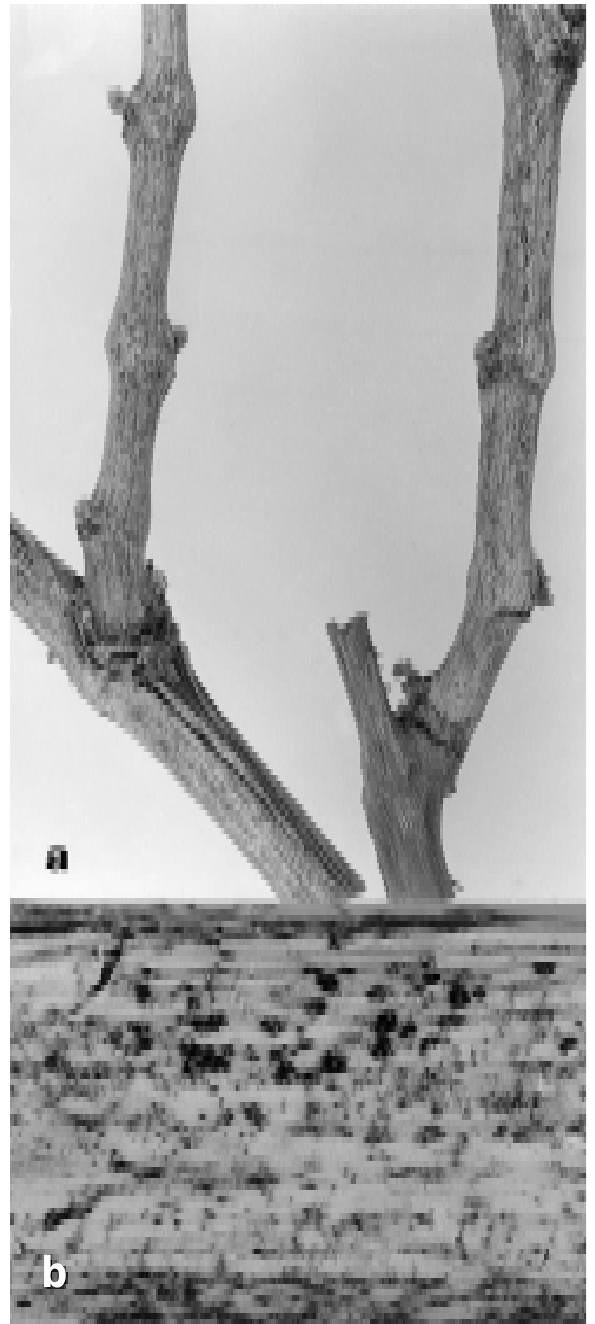
Fig. 1. a. Grapevine canes with a bleached appearance characteristic of excoriose. b. Fruit-bodies of Botryo- sphaeria dothidea